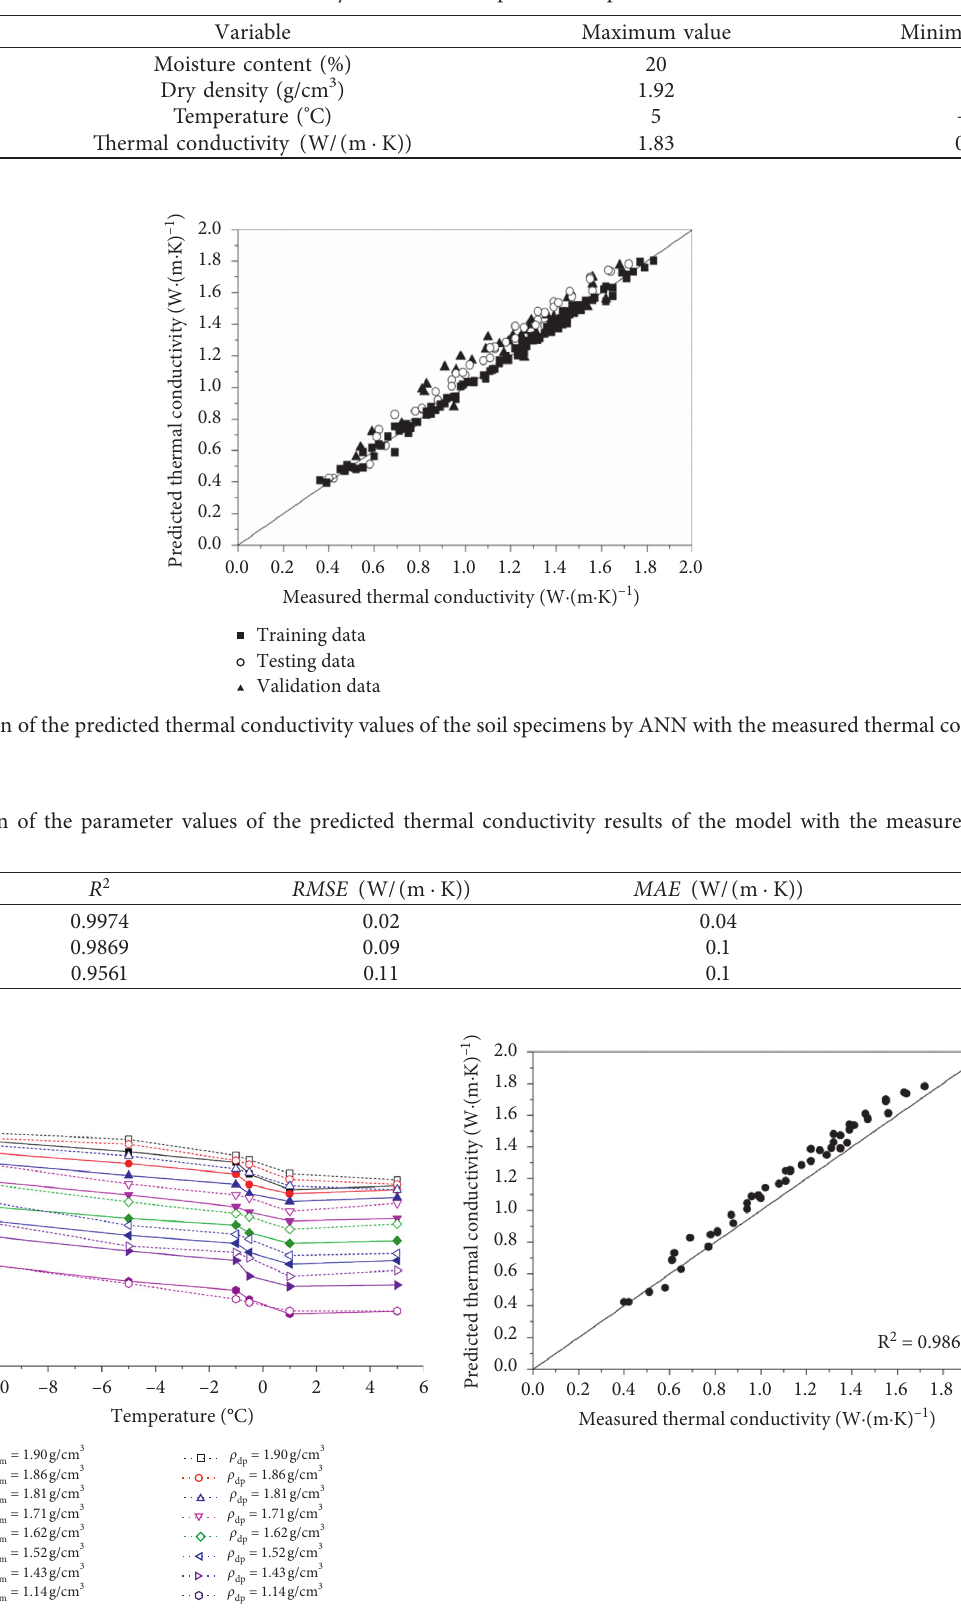
Table 4: Boundary values of the input and output data.